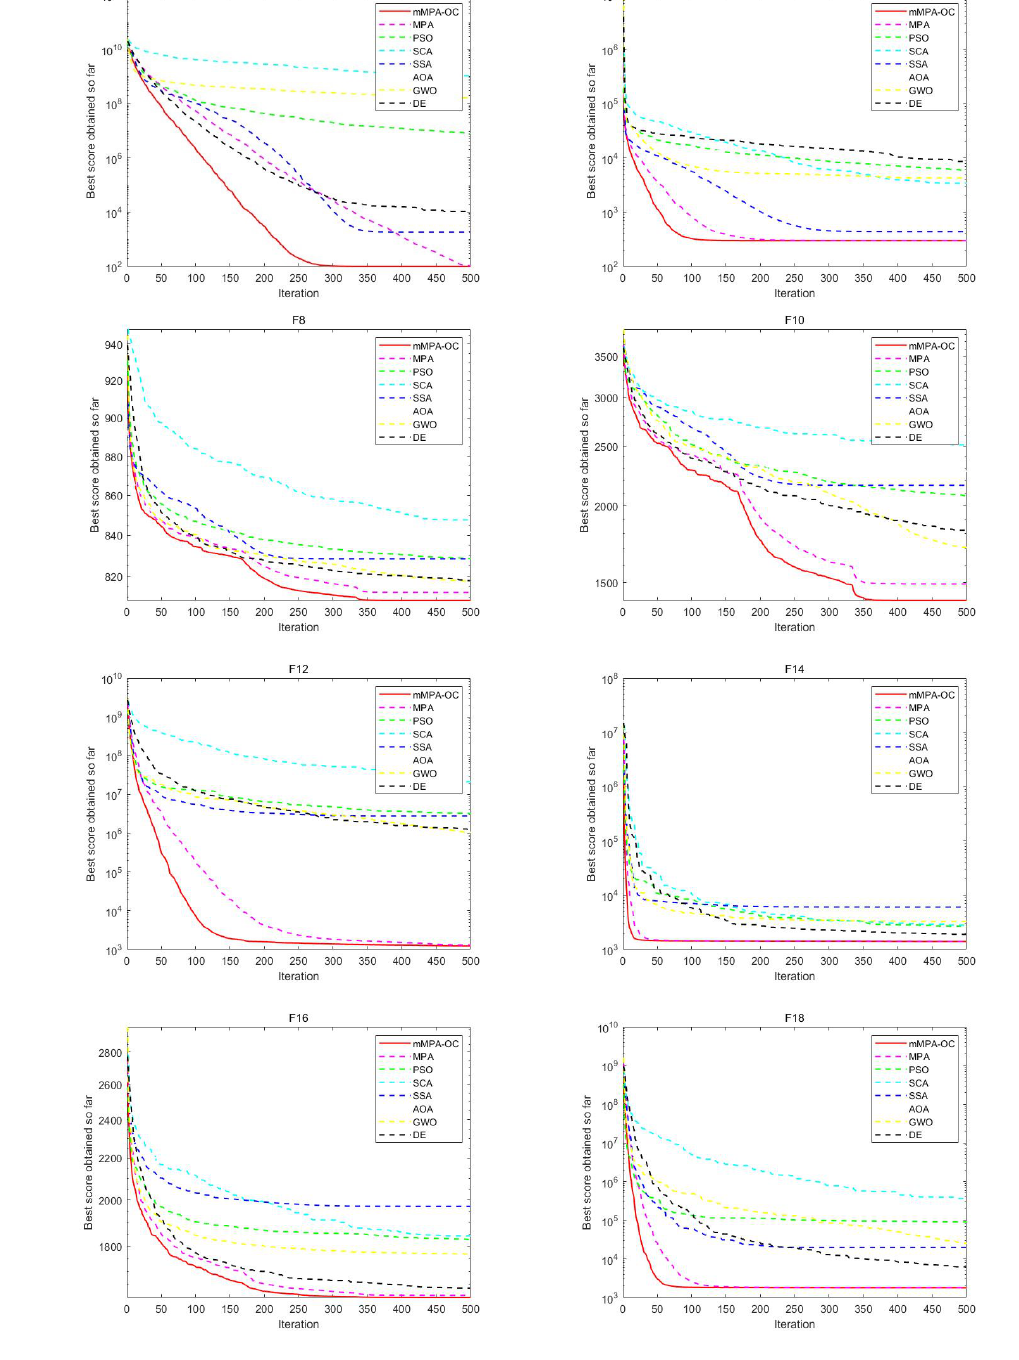
Figure 1. Convergence curve of CEC-2017 test function (10